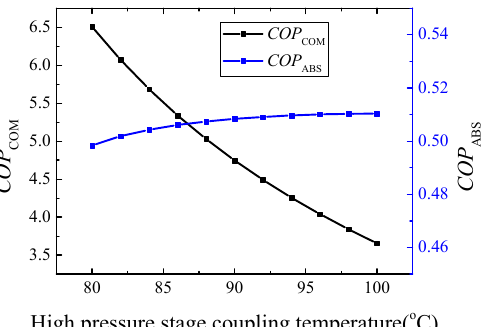
Figure 9. Effect of high pressure stage coupling temperature on sub-cycle COP.